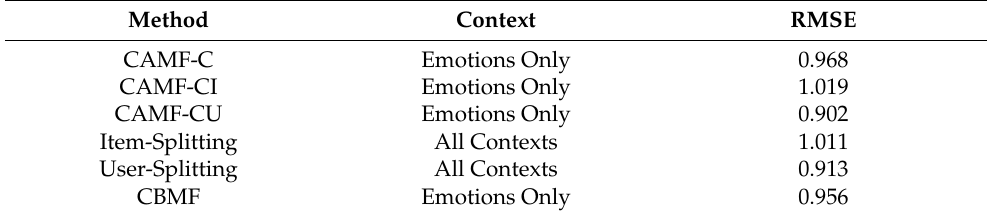
Table 8. Numerical Results of the methods on the LDOSCoMoDa